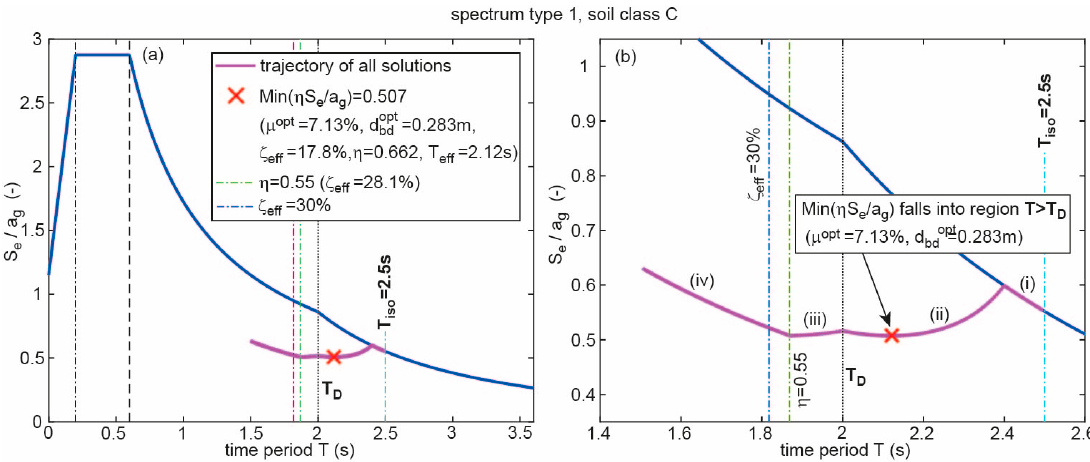
T = 2.5 s and ( b ) according close-up for spectrum type 1 iso